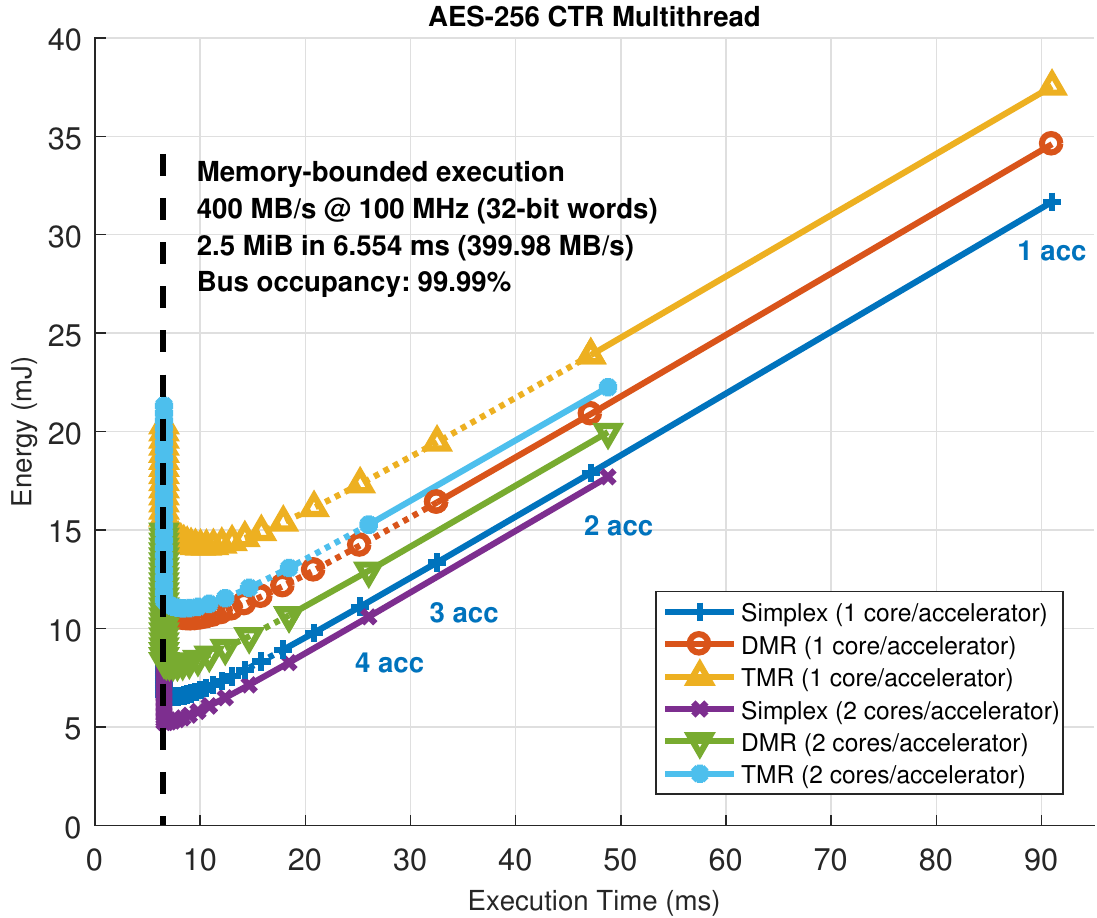
Figure 13. Solution space exploration in the KC705 development board. A computing-bounded algorithm (block cipher) with one or two parallel datapaths per accelerator is used.